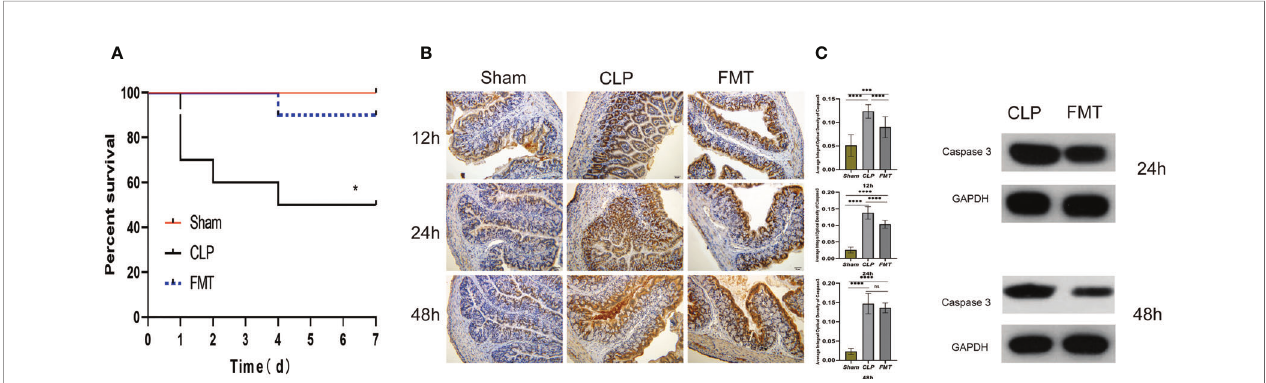
FIGURE 1 | Survival analysis, and caspase 3 expressions among the Sham, CLP, and FMT groups. (A) Seven-day mortality observations in the Sham (red), CLP (black), and FMT groups (blue). There were signi fi cant differences between the CLP group and the other two groups, P < 0.05, but there was no signi fi cant difference between the FMT group and the Sham group; (B) Immunohistochemistry of the colon [under a digital microscope (20 × 10)]. The average integral optical density of caspase 3 between the Sham, CLP, and FMT groups at 12, 24, and 48 h are shown on the right side. (C) Relative expression of caspase 3 compared with GAPDH between the CLP and FMT groups at 24 and 48 h. * P < 0.05, *** P < 0.001, **** P < 0.0001, ns, no statistical difference,